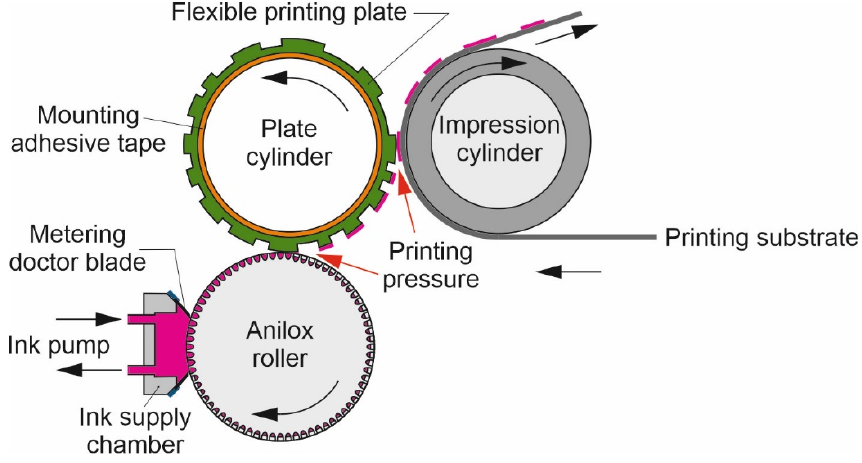
Figure 1. Schematic description of the flexographic printing process.